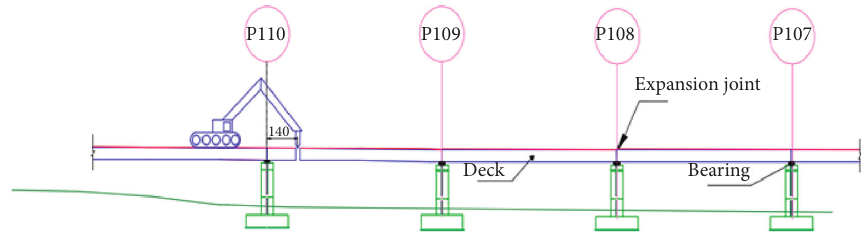
Figure 3: The mechanical demolishing plan of the span.